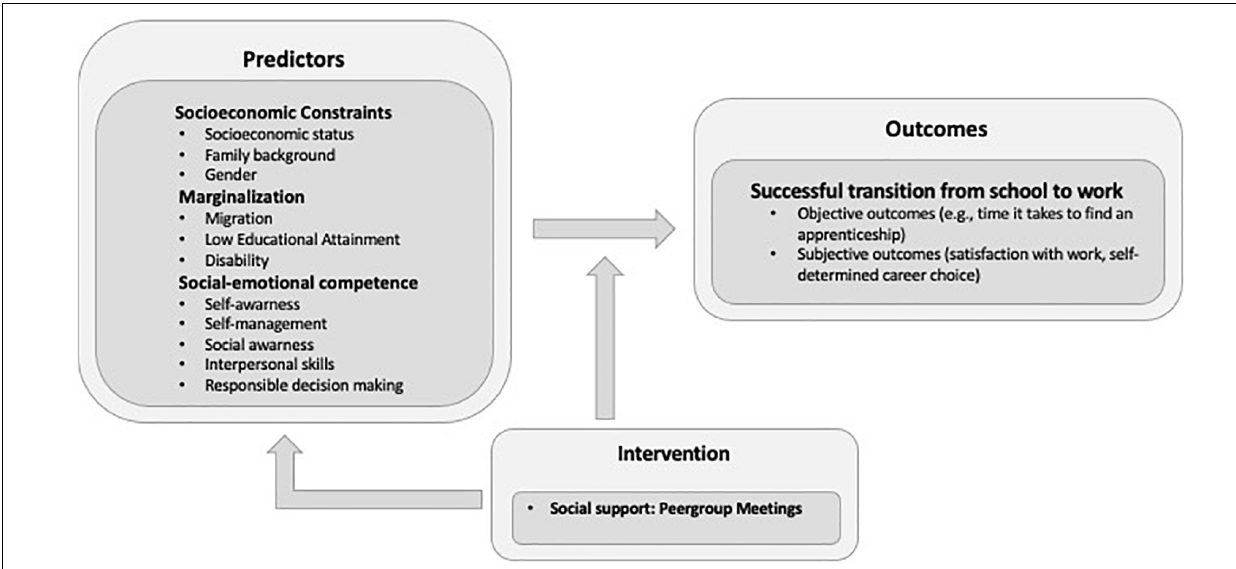
FIGURE 1 | Basic concept of the project “Empower Peers 4 Careers.”